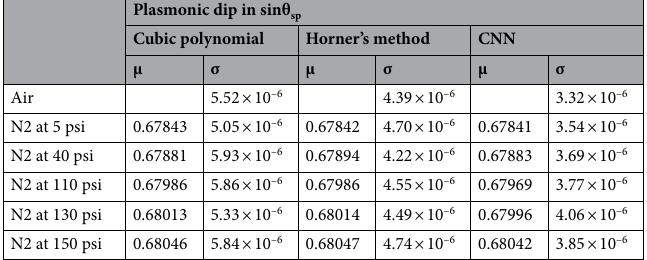
Table 2. Mean and standard deviation values of plasmonic dip from three methods in sinθ